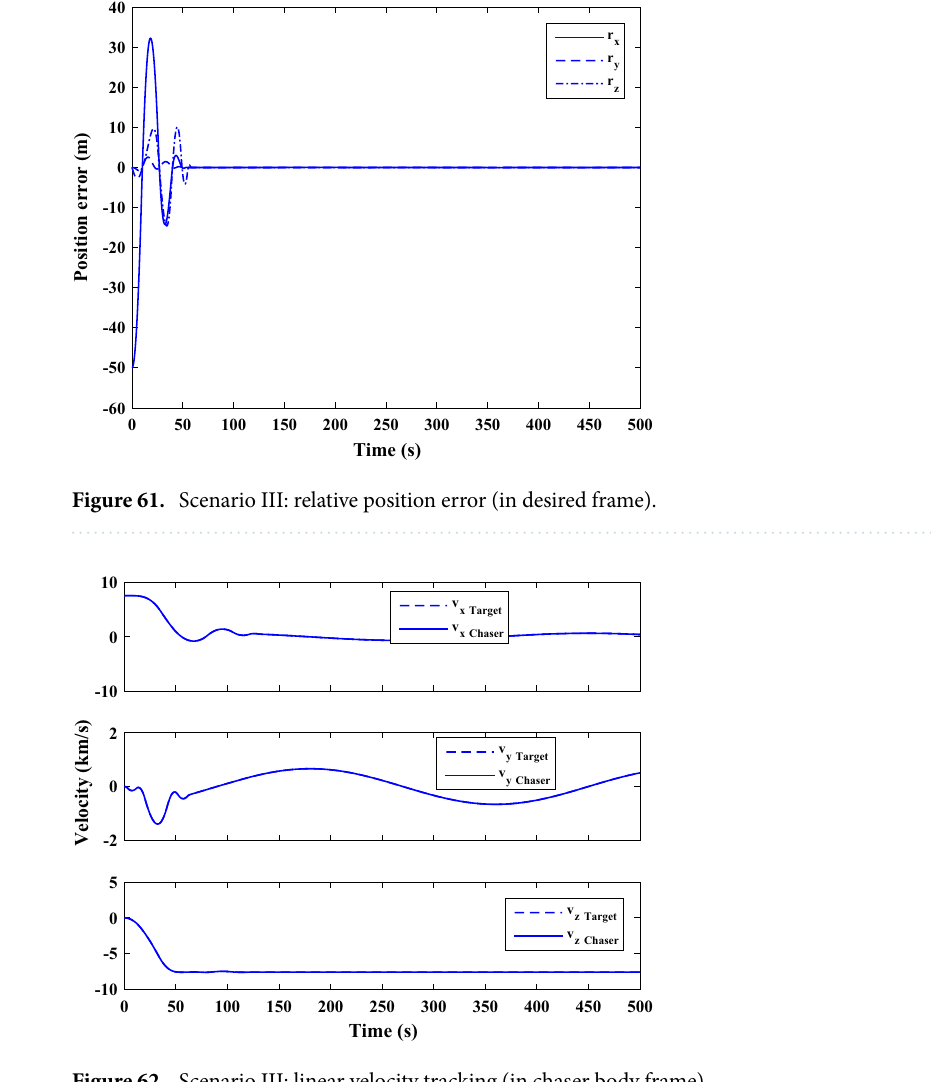
Figure 62. Scenario III: linear velocity tracking (in chaser body frame).